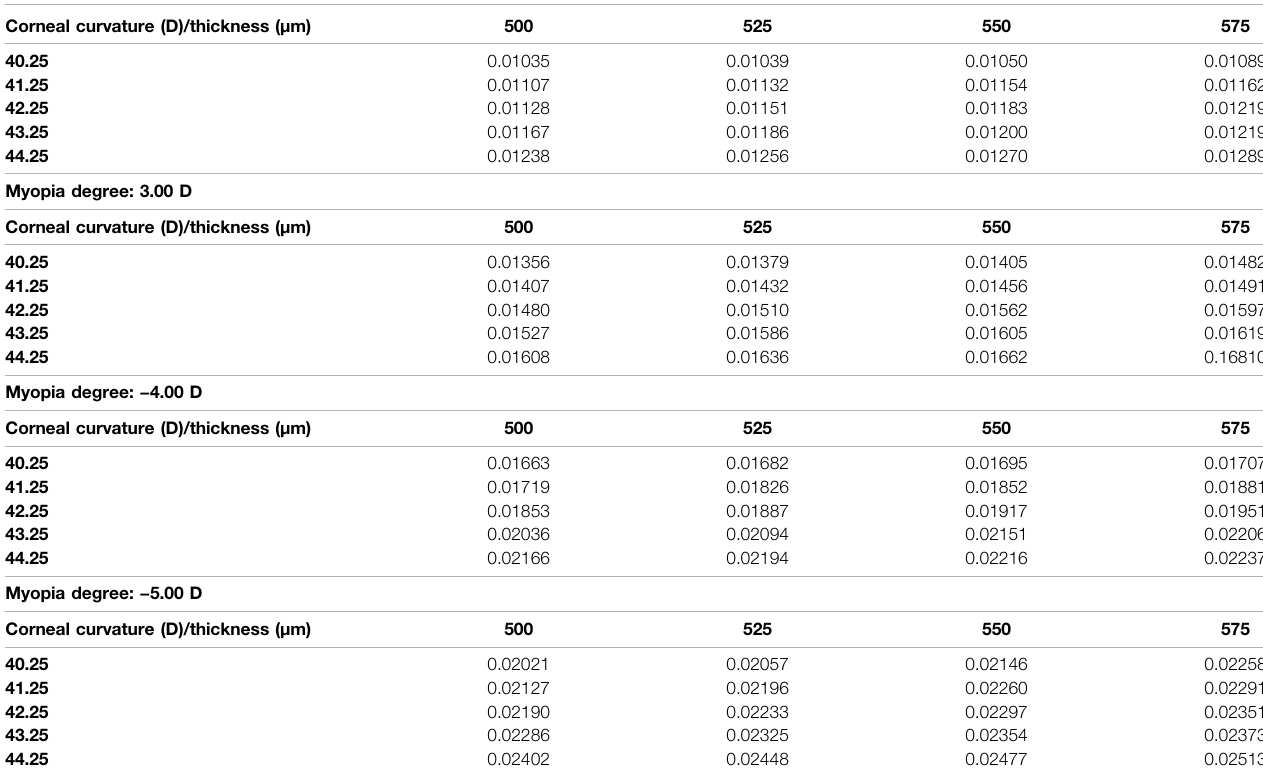
The representative maximum von Mises stress appearing in the central and peripheral areas are shown in Figure 4 and Figure 5 . Quantile Regression Results of Dependent Variables and Independent Variables The quantile regressionresults ofcentralcornealstressandindependent variables are shown in Table 6 . Compared with myopia of − 2.00 D, the central corneal stress value increased when the myopia was − 3.00 D ( β (cid:1) 0.0036, p < 0.001), − 4.00 D ( β (cid:1) 0.0074, p < 0.01), and − 5.00 D ( β (cid:1) 0.0111, p < 0.01). Compared with corneal curvature of 40.25 D, the central corneal stress value increased when the corneal curvature was 41.25D( β (cid:1) 0.0007, p < 0.01),42.25D( β (cid:1) 0.0014, p < 0.01),43.25D( β (cid:1) 0.0019, p < 0.01), and 44.25 D ( β (cid:1) 0.0031, p < 0.01). Compared with a corneal thickness of 500 μ m, the central corneal stress value increased when the corneal thickness was 525 μ m ( β (cid:1) 0.0004, p (cid:1) 0.0298), 550 μ m ( β (cid:1) 0.0007, p < 0.01), and 575 μ m ( β (cid:1) 0.0011, p < 0.01). All models were controlled for the other covariates. The quantile regression results of corneal peripheral stress and independent variablesare shown in Table 7 . In patients with myopia of − 3.00 D ( β (cid:1) 0.0007, p < 0.01) and − 4.00 D ( β (cid:1) 0.0009, p < 0.01), the corneal peripheral stress increased compared with patients with myopia of − 2.00 D. In patients with corneal curvature of 42.25 D ( β (cid:1) 0.0007, p (cid:1) 0.0324), 43.25 D ( β (cid:1) 0.0015, p < 0.01), and 44.25 D (